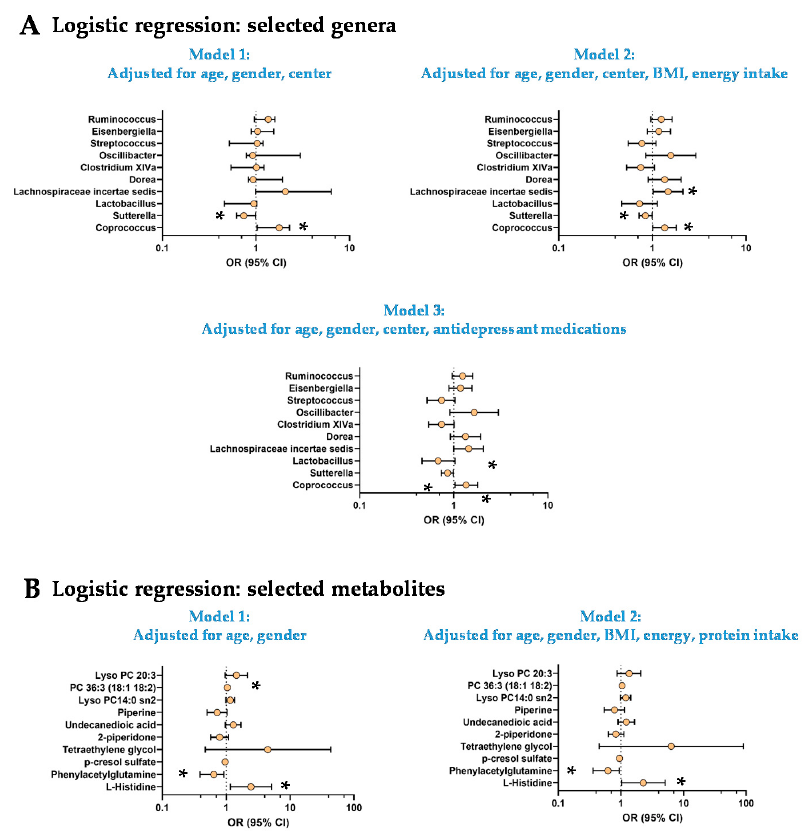
Figure 1. Logistic regressions for selected genera and metabolites. Logistic regression with TOP10 microbial genera ( A ) and metabolites ( B ). Odd ratio and 95% confidence intervals were represented. * significant results ( p < 0.05). A. Model 1: Logistic regression adjusted for age, gender and center; Model 2: Logistic regression adjusted for age, gender, center, BMI, energy intake; Model 3: Logistic regression adjusted for age, gender, center and antidepressant medications. B. Model 1: Logistic regression adjusted for age and gender; Model 2: Logistic regression adjusted for age, gender, BMI, energy and protein intake. PC: